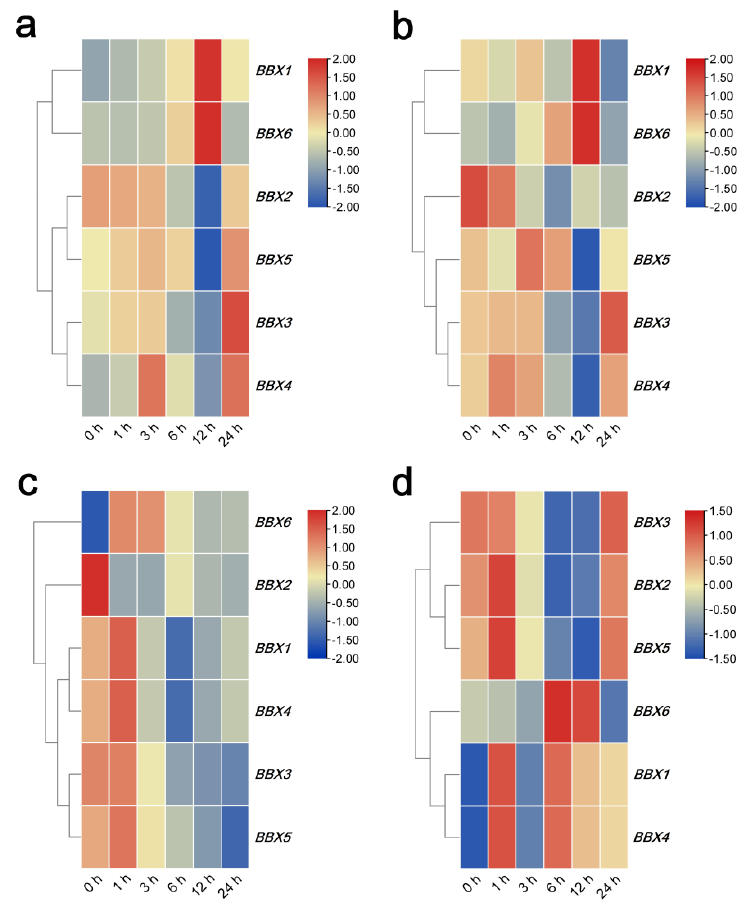
Figure 6. Expression profiles of IgBBX genes in leaf tissue following exposure to ( a ) salinity stress, ( b ) drought stress, ( c ) high temperature (40 ◦ C), and ( d ) wound treatments. Blue and red indicate down-regulated and up-regulated transcript abundance, respectively, compared to the relevant controls (0 h sample is an untreated sample). Bar on the top right corner represents log 2 transformed values.